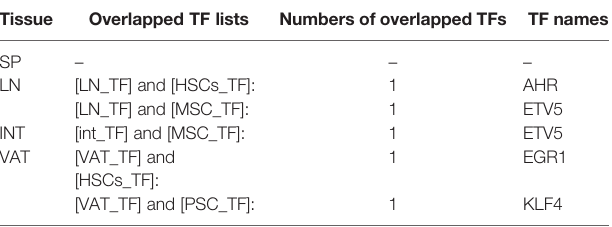
TABLE 14 | The transcription factors (TFs) shared between four tissue Treg (SP, LN, int, VAT) and three types of stem cells (HSC, MSC, and PSC)